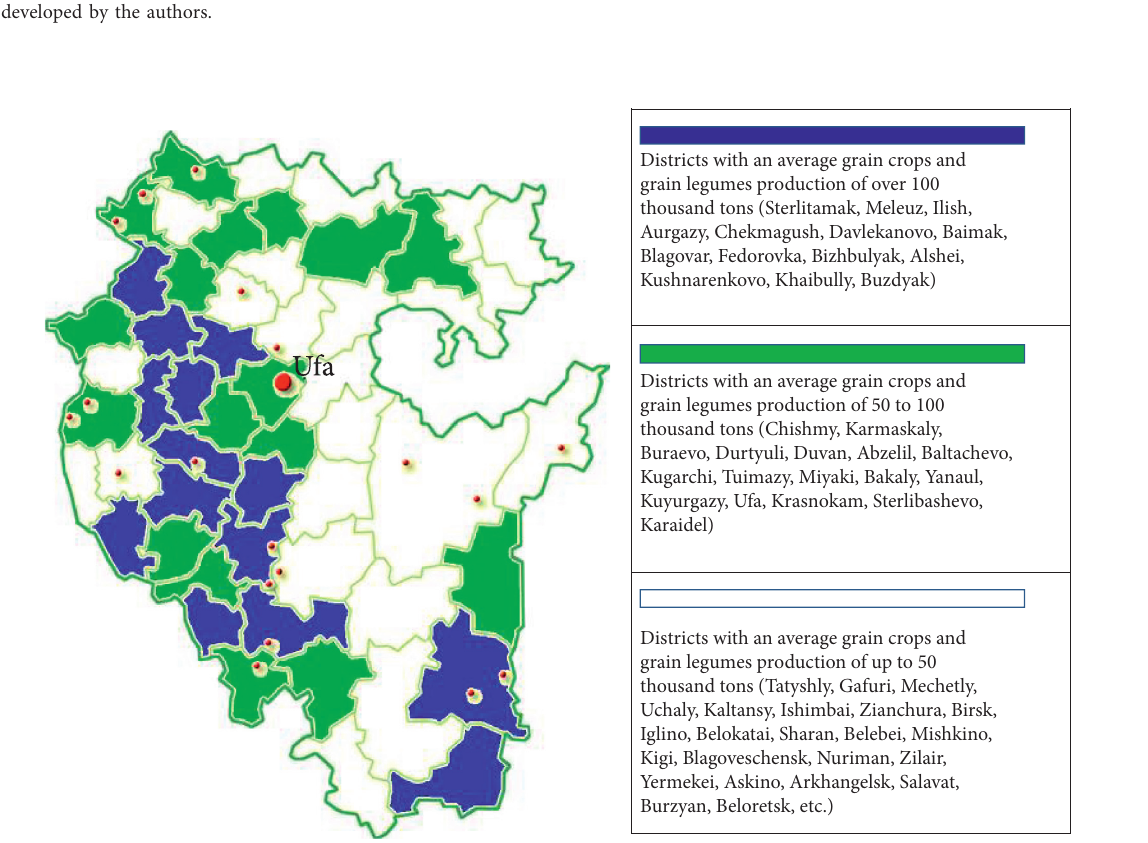
Figure 2: Territorial model of priority of participation in implementation strategic directions of the municipal regions of the republic in direction of development of grain production.